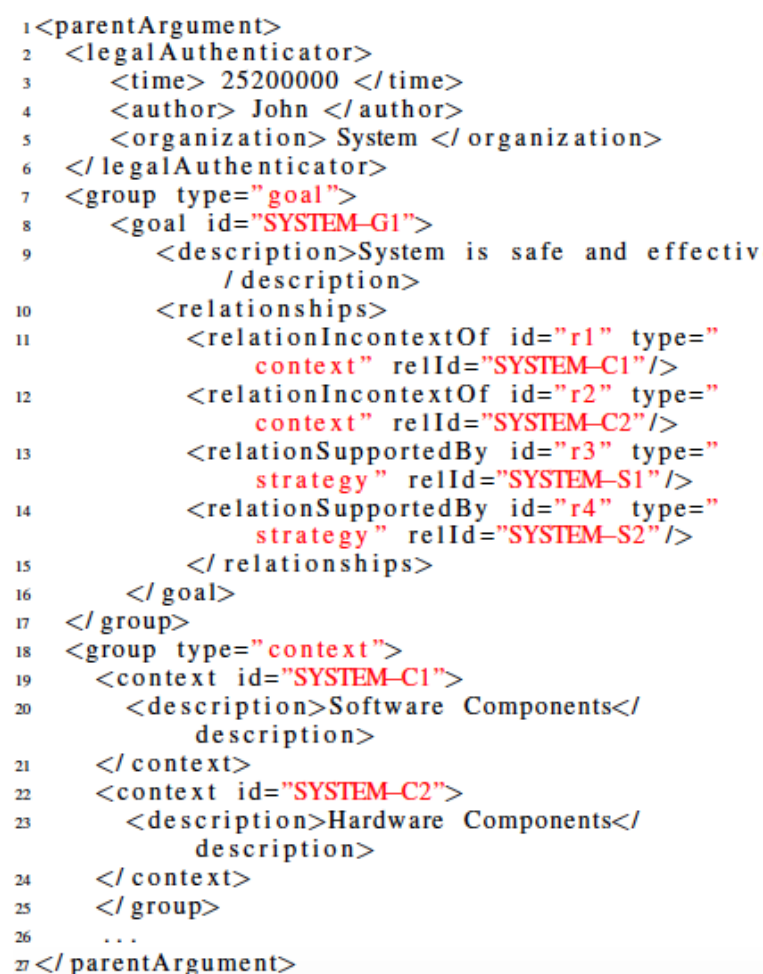
Figure 5. Sample of the ACES specification for the assurance case of Figure